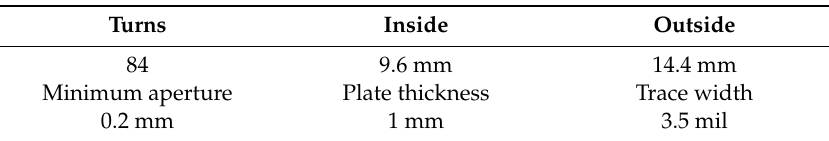
Table 1. PCB coil